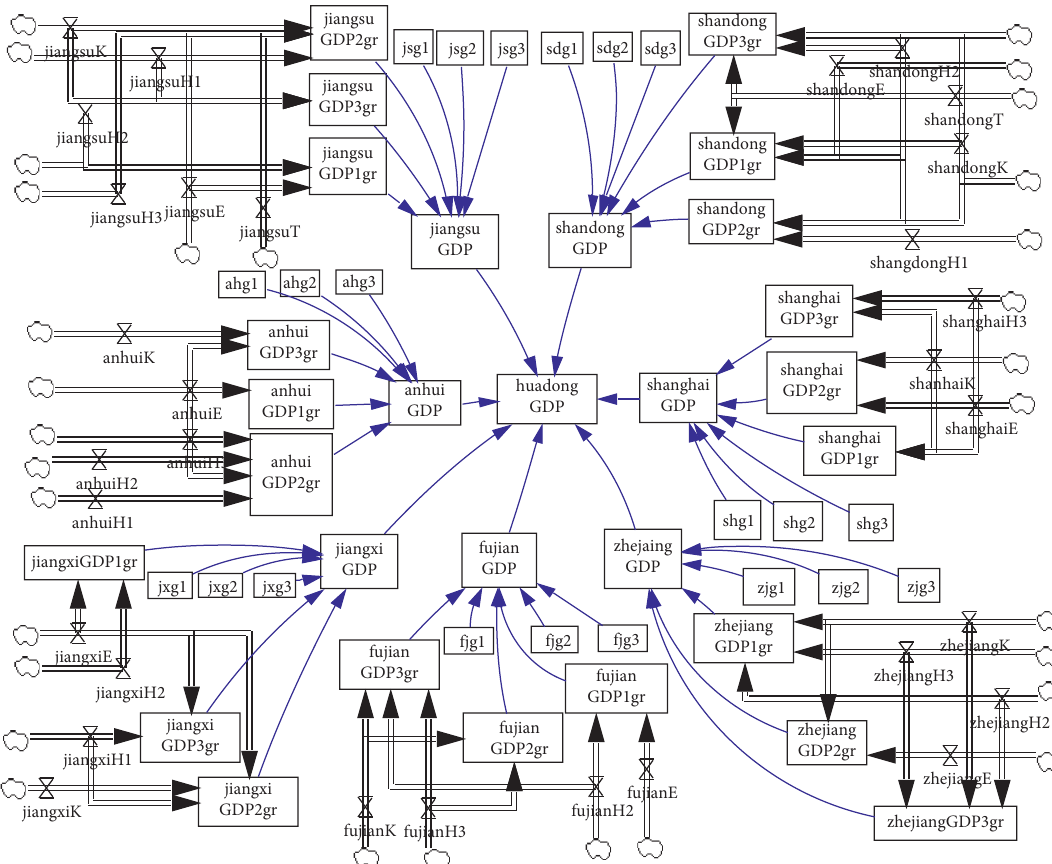
Figure 1: Flowchart of an economic growth simulation system in East China.